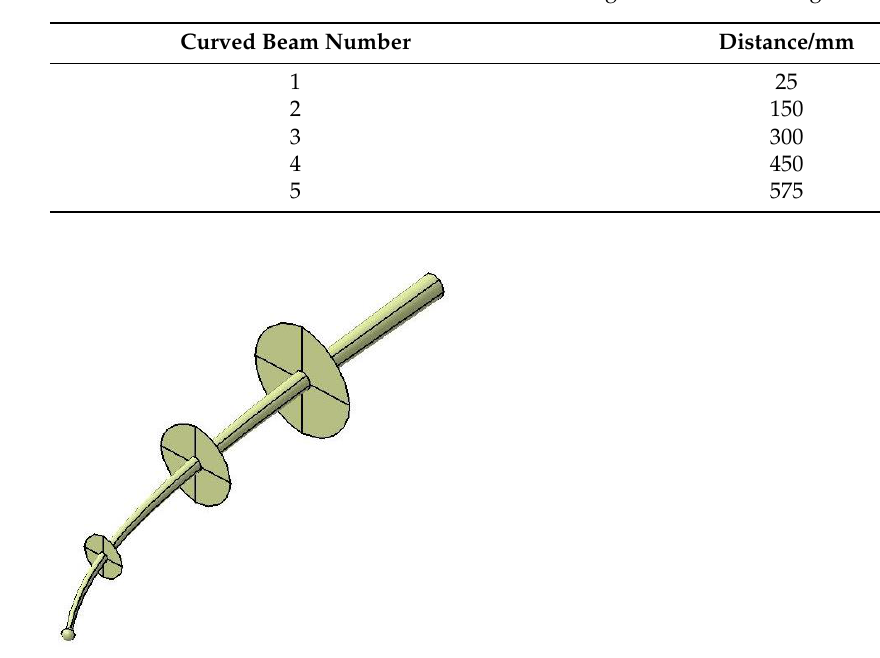
Table 2. Distance between the curved beam and the wing root of the outer segment.